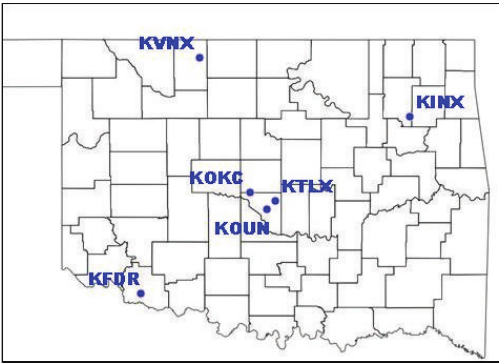
Figure 1: Map showing weather radars over Oklahoma. Shown are four WSR-88D Doppler radars KVNX, KTLX, KFDR, and KINX as well as two other radars: KOUN, an experimental dual-polarization WSR-88Dradar,andKOKC,aTDWRradaroperatedbyWillRogers Airport in Oklahoma